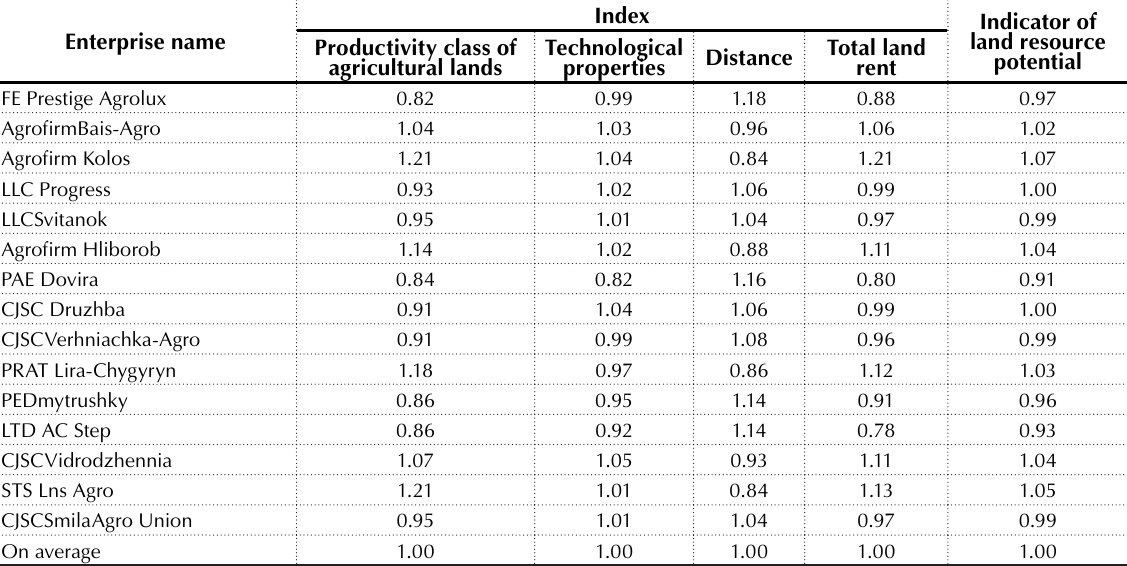
Table 5. Index assessment of the economic situation of land resource potential of some agricultural enterprises in Cherkasy region in 2016 Source: Developed on the basis of financial and analytical data of